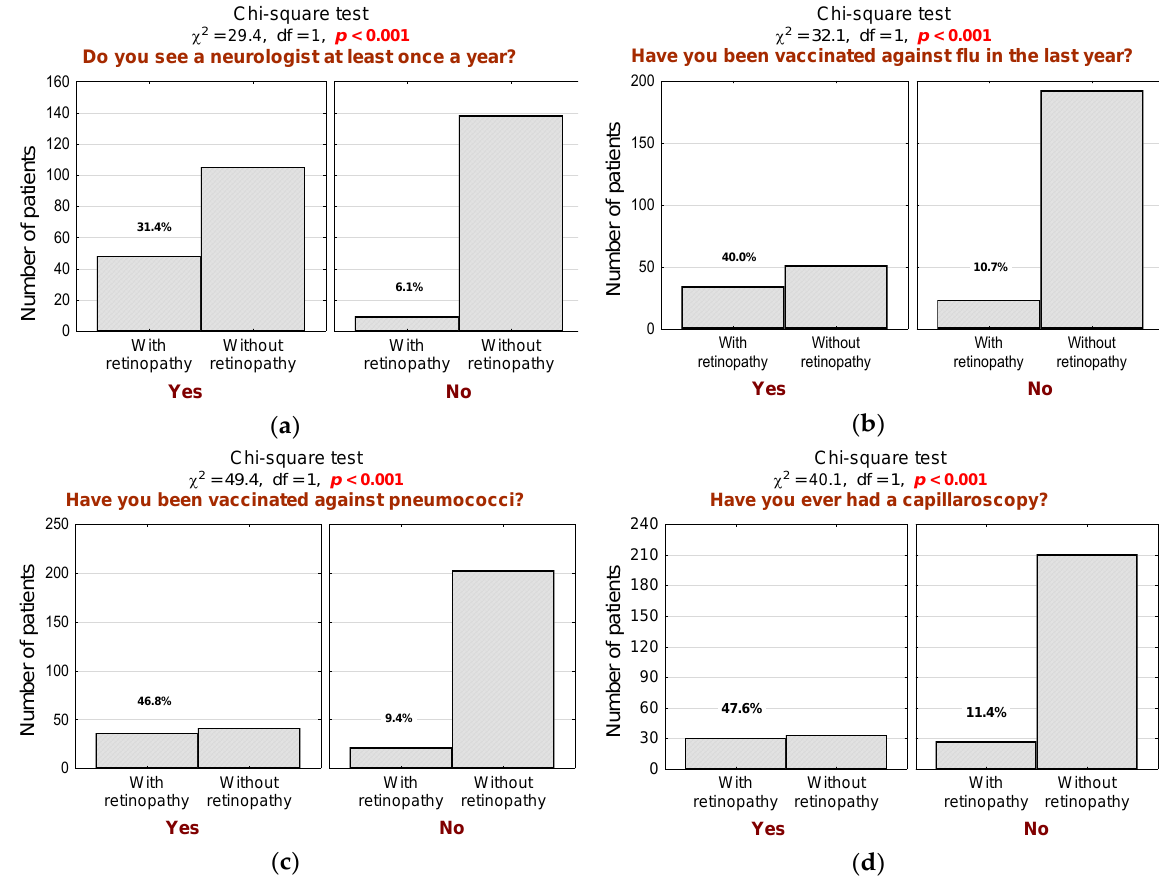
Figure 6. ( a ) Number ( n ) and percentage (%) of patients in groups that differ in the presence of diabetic retinopathy and in